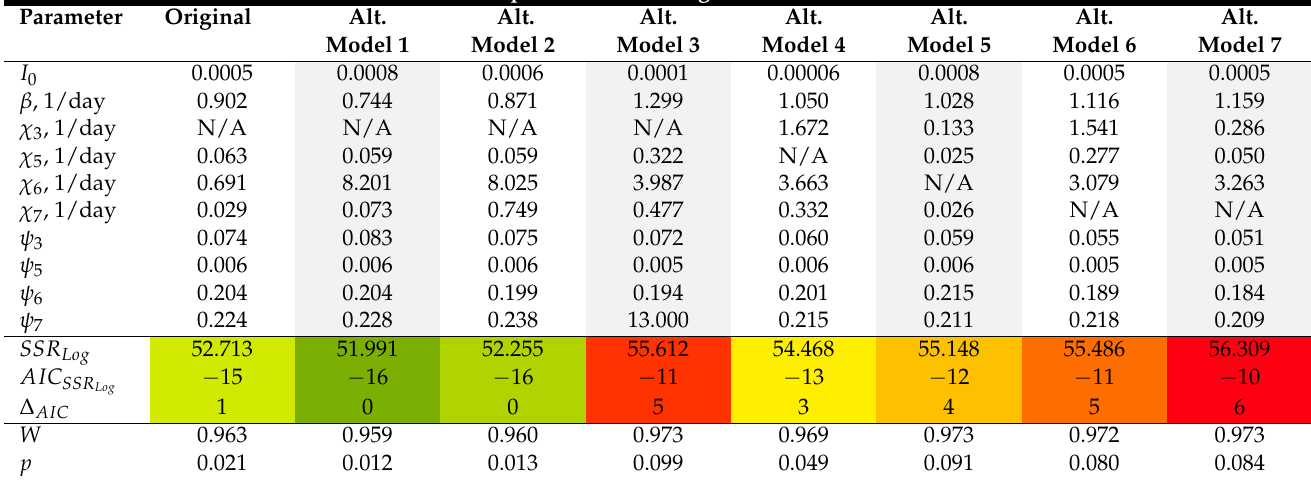
Table 2. Several alternative models provide similar fits of the virus spread data with different param- eter sets. We fitted seven alternative models for virus spread kinetics (given in Equations (4)–(15)) to the data on viral spread in plants using least squares with a logarithmic transform (see Equation (35)). Along with parameter values for every model we provide the total error ( SSR Log ), AIC LS (difference in AIC between the model with the lowest AIC and all other models). We also show the results of the Shapiro-Wilk normality test ( W and p value) applied to the residuals of the fitted models. N/A stands for “Not Available” for parameters that were not present in a given alternative model. Coloring indicates the difference in the quality of a model fit as compared to the best fit models (green—better fit, red—worse